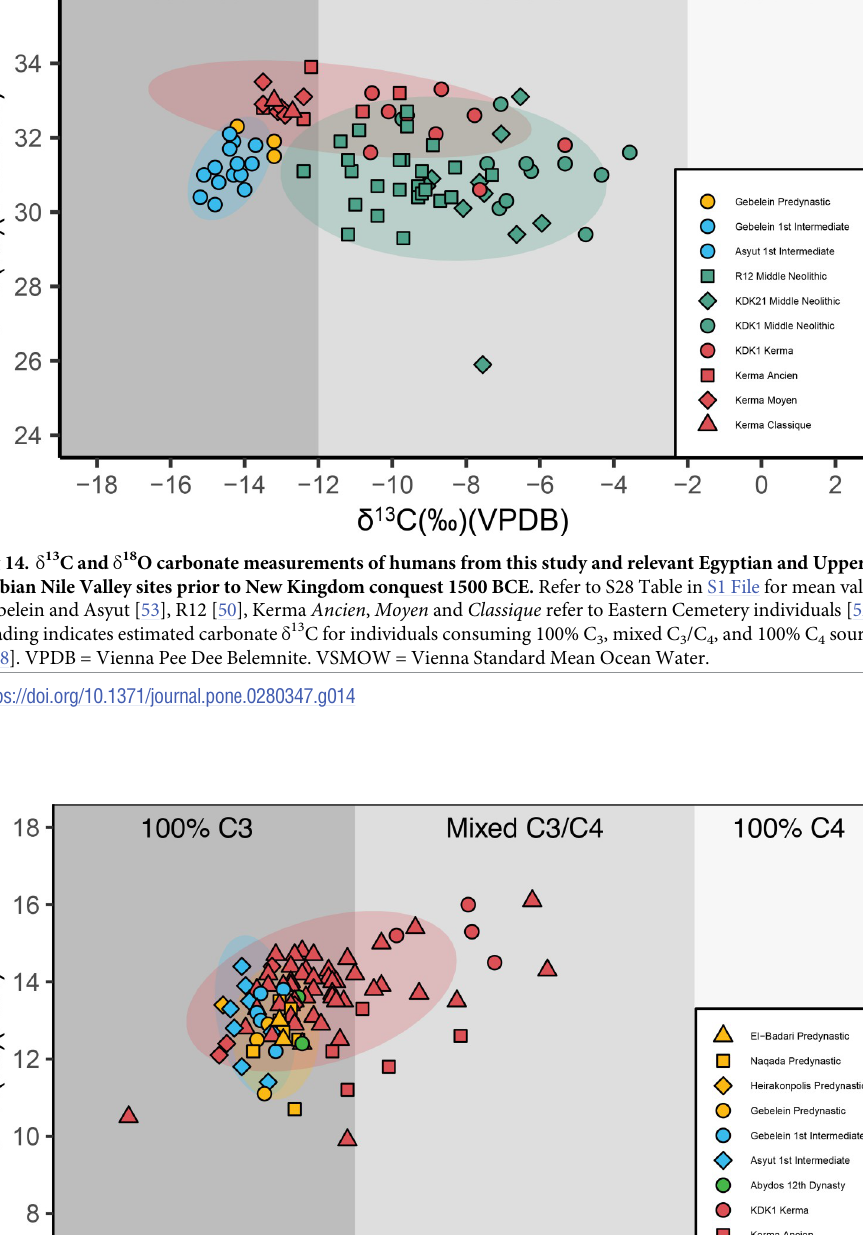
PLOS ONE | https://doi.org/10.1371/journal.pone.0280347 February 2,